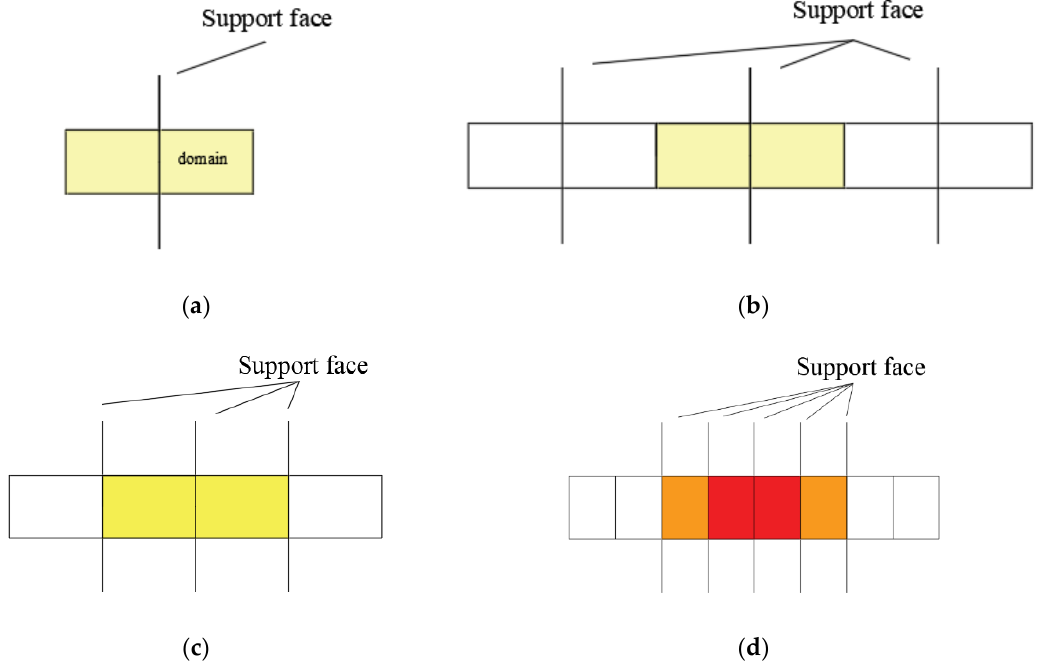
Figure 17. Support influence domain diagram and three typical situations: ( a ) influence domain diagram ( b ) support spacing = domain length, ( c ) support spacing = 50% of the domain length, and ( d ) spacing = 25% of domain length (the colors represent the magnitude of the effect of the influence domain).